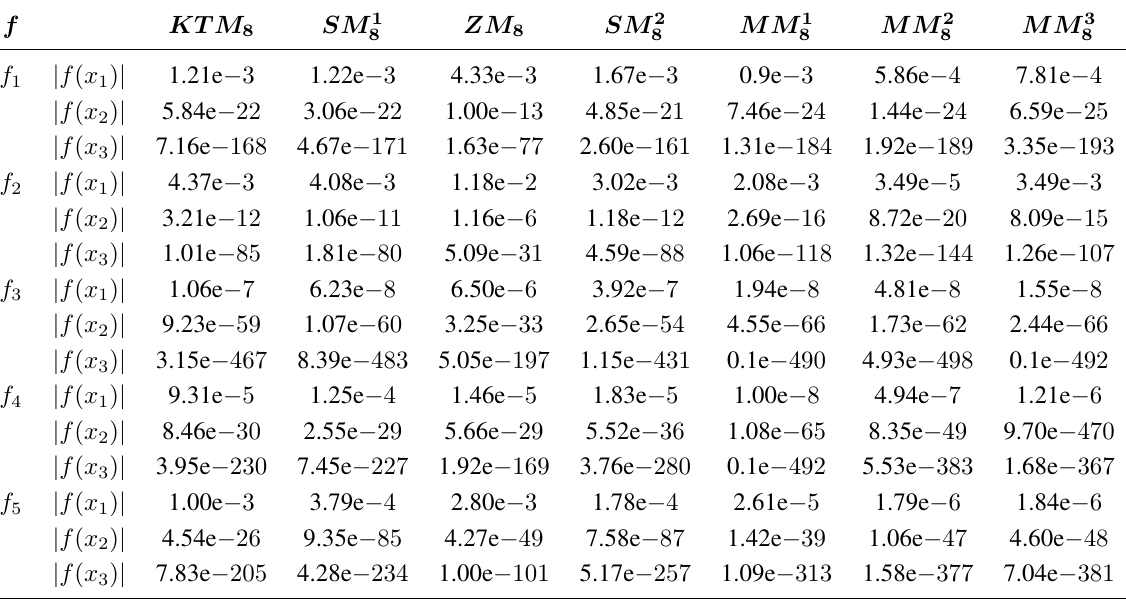
Table 2. Comparison of different methods for smooth functions.